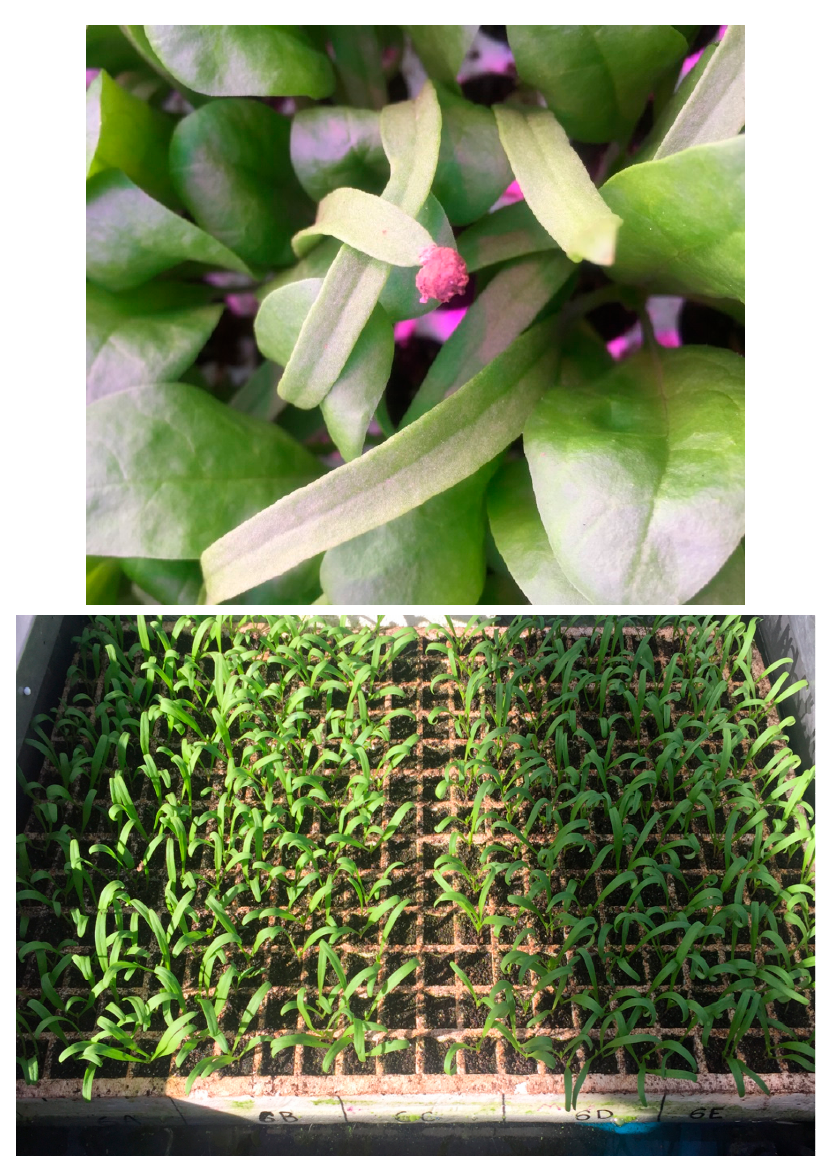
Figure 9. ( top ) Pericarp stuck on cotyledon late in the crop cycle; ( bottom ) A flat one week after floating with few pericarps.